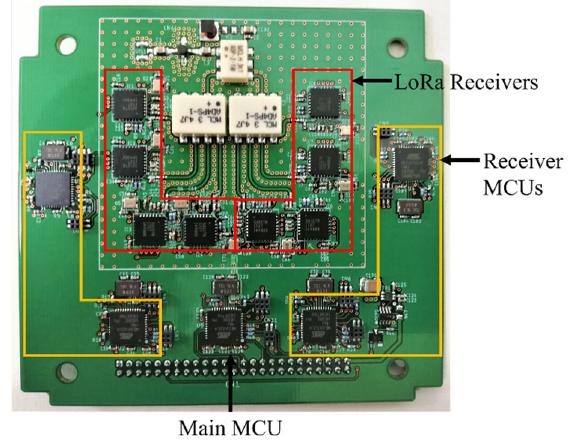
Figure 6. S&F receiver payload design.